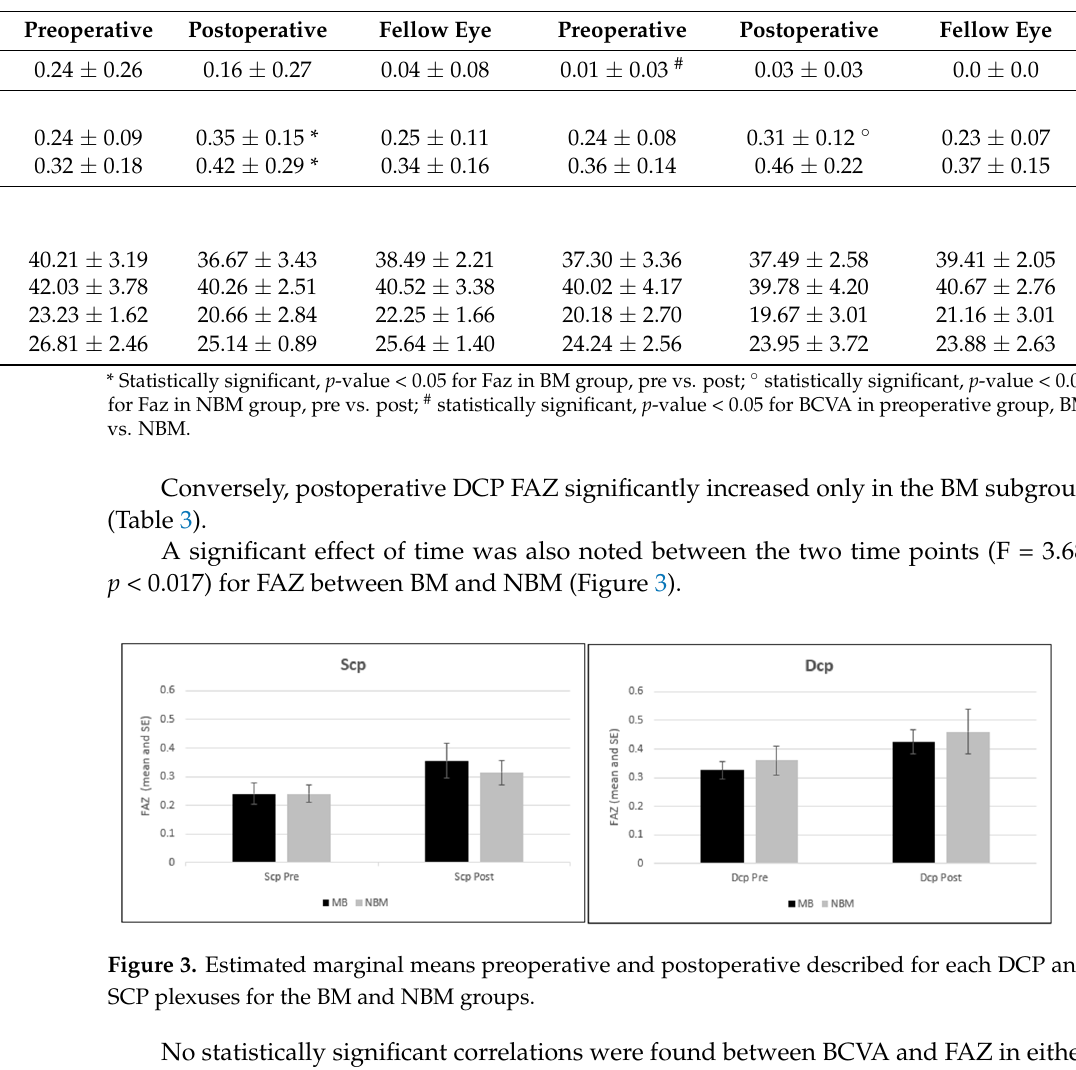
Table 3. Best-corrected visual acuity and optical coherence tomography angiography mean values for the BM and NBM groups.